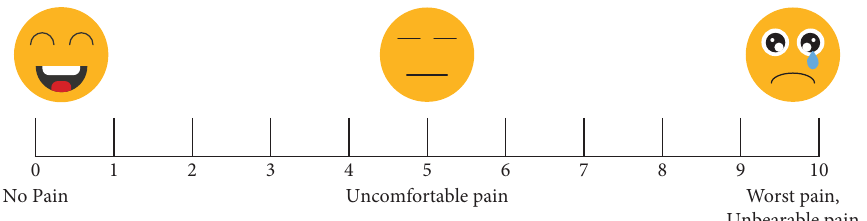
Figure 2: Patients were instructed to circle the number in the line above that refects their current level of pain at rest and during movement. Min: minutes; h: